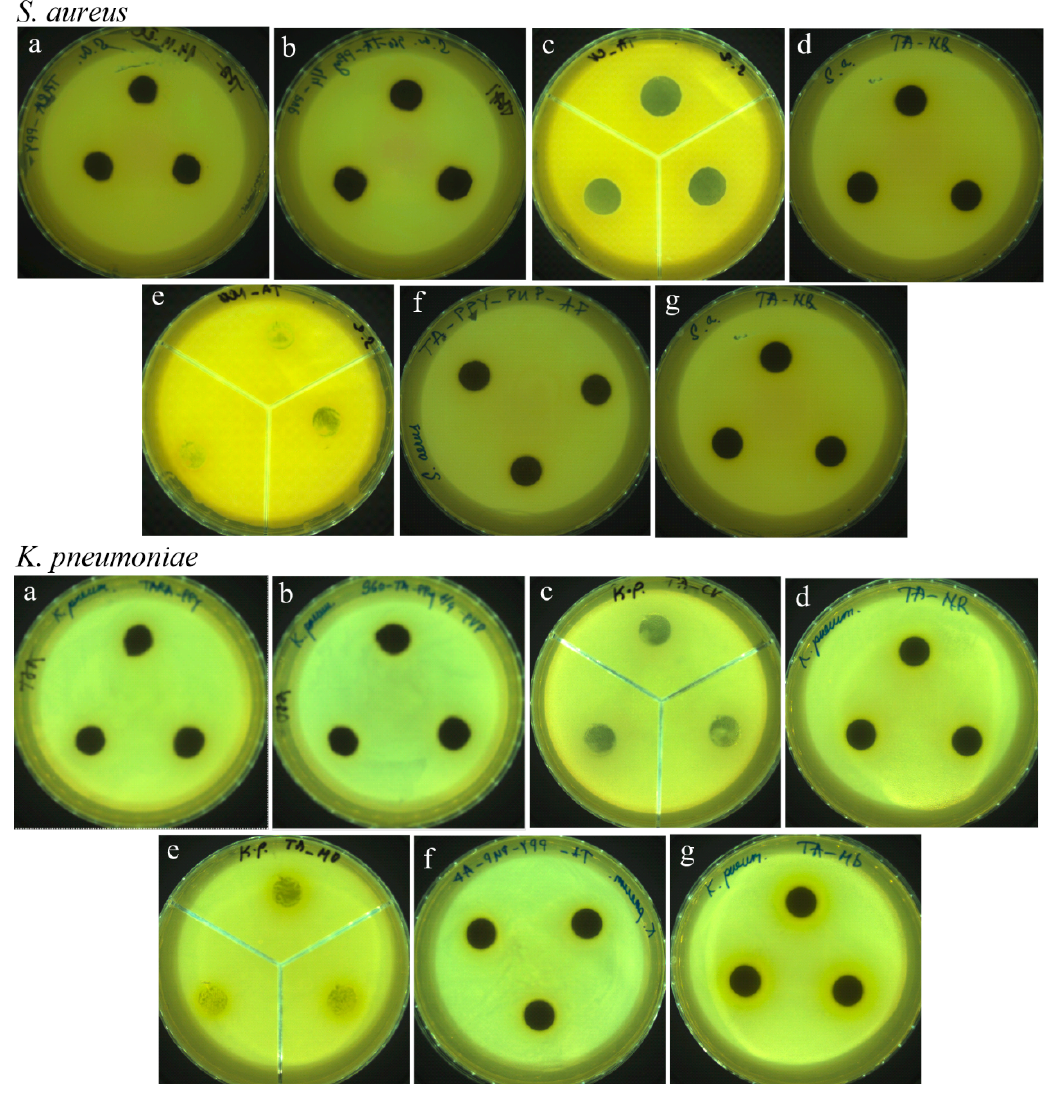
Figure 6. Images of inoculated agar plates after 24 h with coated leather materials with ( a ) polypyrrole, ( b ) polypyrrole–PVP, and polypyrrole–PVP in the presence of ( c ) crystal violet, ( d ) neutral red, ( e ) methyl orange, ( f ) acriflavine, and ( g ) methylene blue in the testing of the antibacterial effect on bacterial strains of Staphylococcus aureus ( upper part ) and Klebsiella pneumoniae ( lower part ) .